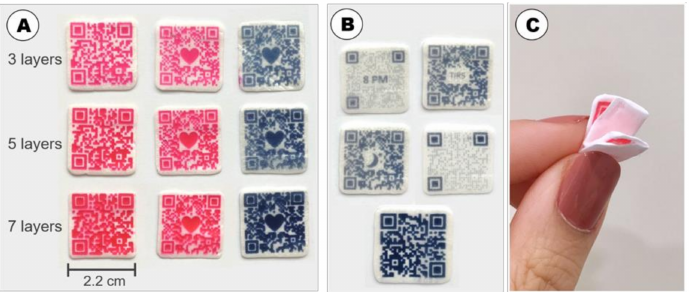
Figure 1. Photographs of ( A ) inkjet-printed DEEP, using solid foams as substrate with three, five and seven subsequently imprinted layers, where the ink contained either red or blue coloring agents; ( B ) inkjet-printed DEEP with different patterns (original and dots), incorporated images (moon and text; TIRS = Tuesday), and sizes (2 × 2 cm 2 and 2.2 × 2.2 cm 2 ) (top four DEEP are imprinted with 3 layers and bottom DEEP is imprinted with 7 layers). ( C ) Flexibility of an inkjet-printed